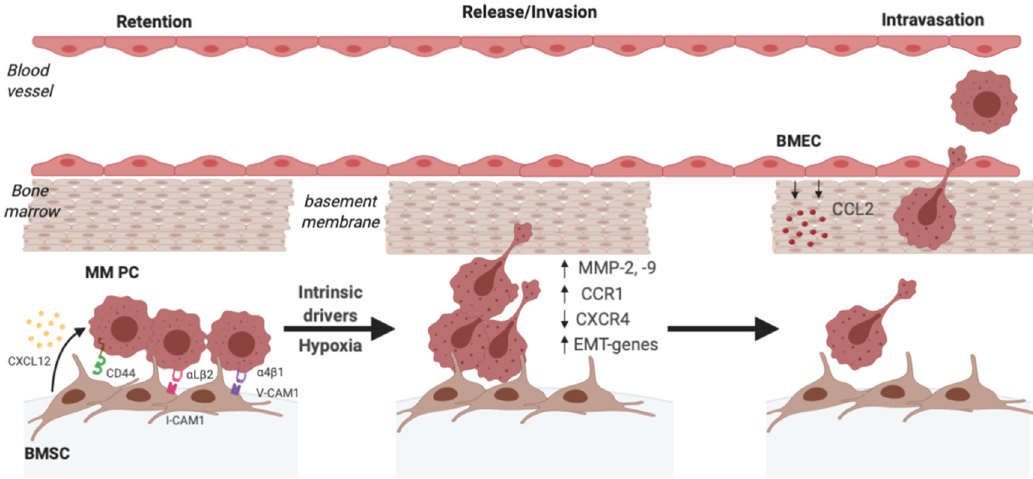
Figure 1. Multiple myeloma (MM) plasma cell (PC) intravasation is dependent on overcoming adhesive interactions within the bone marrow (BM) and invading the vasculature basement membrane. Release from the stromal niche is likely mediated by both external drivers such as hypoxia, and internal drivers in subclones with increased propensity to disseminate. This leads to a decrease in MM PC expression of key adhesion molecules such as α 4 β 1, allowing the MM PCs to overcome the retention signal mediated by CXCL12 produced by bone marrow mesenchymal stromal cells (BMSCs). Hypoxic MM PCs upregulate epithelial to mesenchymal transition (EMT)-like genes, decrease their cell surface expression of CXCR4 and increase their expression of CCR1 to mediate mobilisation from the BM niche. Upregulation of matrix metalloproteins-2 and -9 then allows invasion into the vasculature basement membranes and intravasation into the peripheral circulation during dissemination to a new site.